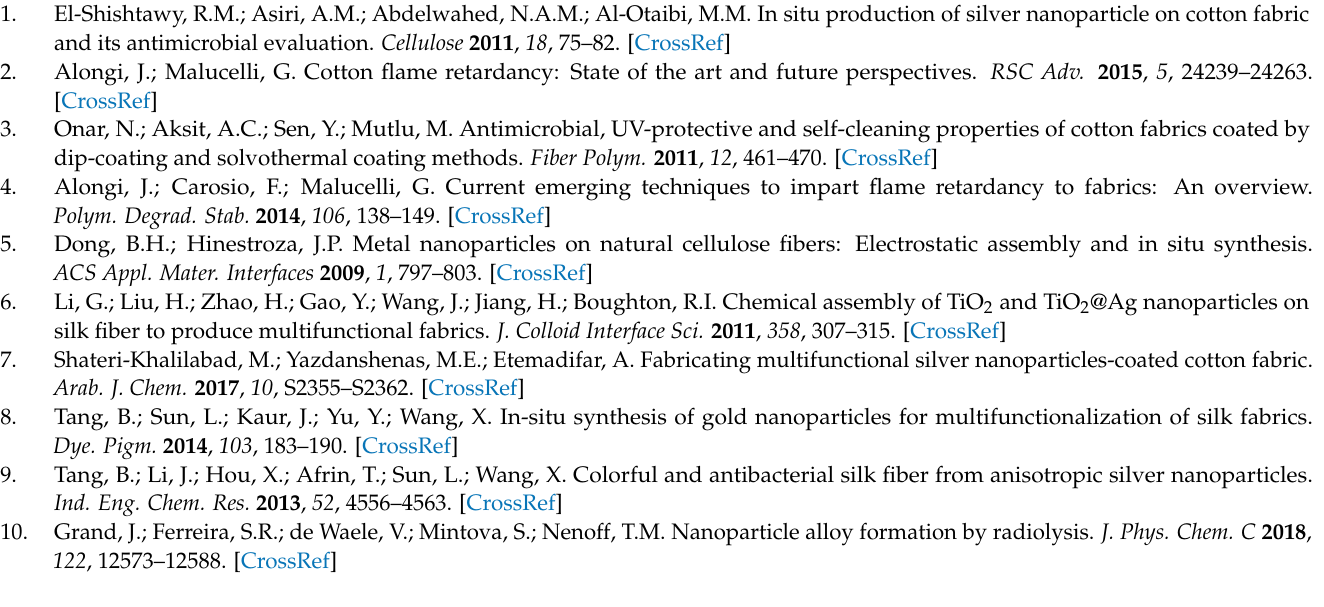
the upper panel. Figure S6: Comparison of total efficiency of 5 nm gold NP impregnation at 0.1 and 0.3 O.D. Figure S7: FTIR-ATR changes in secondary structure content as a function of Au NP size for Mulberry (A), Eri (B), Muga (C), and Tasar (D) silks. Black squares ( (cid:3) ) are inter β -sheets, red circles (O) are β -turns, blue triangles ( ∆ ) are α -helices and random coils, inverted green triangles ( ∇ ) are intra β -sheets. Figure S8: FTIR-ATR change in crystallinity for Mulberry (A), Eri (B), Muga (C), and Tasar (D) silks. Black squares ( (cid:3) ) are scCO 2 samples, red circles (O) are control samples. The horizontal line is the crystallinity in native silk. We found that for scCO 2 treatment alone, the crystallinity was not significantly different from the native silks. Figure S9: FTIR-ATR changes in tyrosine ratio for Mulberry (A), Eri (B), Muga (C), and Tasar (D) silks. Black squares ( (cid:3) ) are scCO 2 samples, red circles (O) are control samples. The horizontal line is the tyrosine ratio in native silk. We found that for scCO 2 treatment alone, the tyrosine ratio was not significantly different from the native silks. Figure S10: SEM images of native (A, scale bar 5 µ ) and impregnated (C, scale bar 10 µ ) silk fibers. The white squares represent the areas where the EDX spectra were collected. EDX spectra of native (B) and impregnated (C) silk fibers. The spectra showed only weak gold signals at 2.5, 7, 9.5, 10.5, 11.5, and 13.5 keV (D). Figure S11: FTIR-ATR changes in secondary structure content as a function of Au NP concentration. Black squares ( (cid:3) ) are inter β -sheets, red circles (O) are β -turns, blue triangles ( ∆ ) are α -helices and random coils, inverted green triangles ( ∇ ) are intra β -sheets. Figure S12: Pareto charts of the standardized effect from the full factorial analysis. The red dotted line is the standardized value above which a factor or combination of factors is considered significant ( α level = 0.1). Table S1: Gold nanoparticles concentration and mass. Table S2. Consensus assignment for silk secondary structures determination by